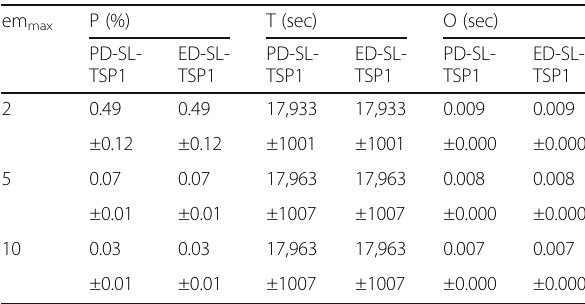
Table 7 Genome workload: effect of em max on P , T , and O